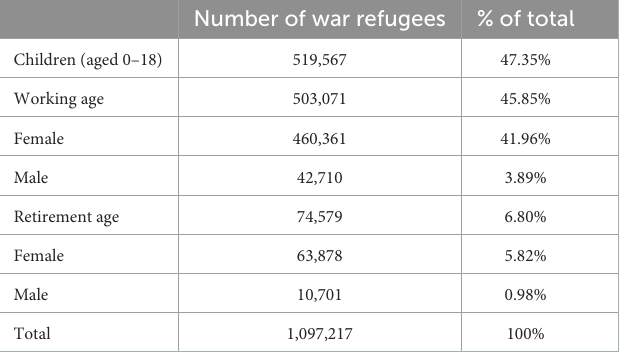
Source:DuszczykandKaczmarczyk(2022),basedonthePESELregister,dataasof15May2022.